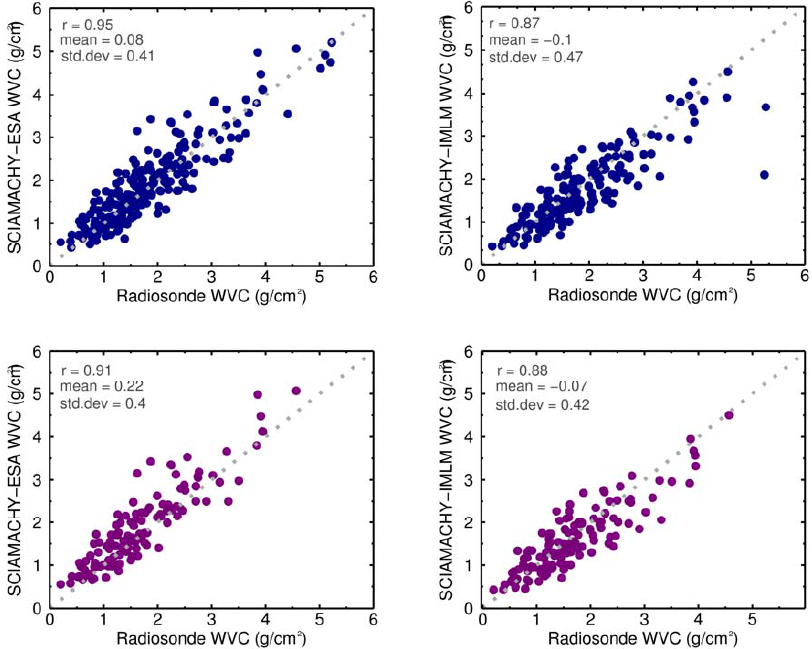
Fig. 17. Comparison between collocated radiosonde WVC and SCIAMACHY-IMLM and SCIAMACHY-ESA WVC amounts for June 2009, for measurements performed over land. The top left figure shows radiosonde WVC compared to SCIAMACHY-ESA for cloud-free conditions according to the SCIAMACHY operational cloud cover (OCRA) product. The top right figure shows the comparison between radiosonde and SCIAMACHY-IMLM WVC amounts for cloud-free conditions according to the SPICI cloud cover product. The two bottom figures indicate comparisons between collocated radiosonde WVC and SCIAMACHY-ESA (bottom left) and SCIAMACHY-IMLM (bottom right) over land for cloud-free conditions according to both SPICI and OCRA cloud cover fraction. The correlation coefficient, mean and standard deviation (gcm − 2 ) are shown in each figure.